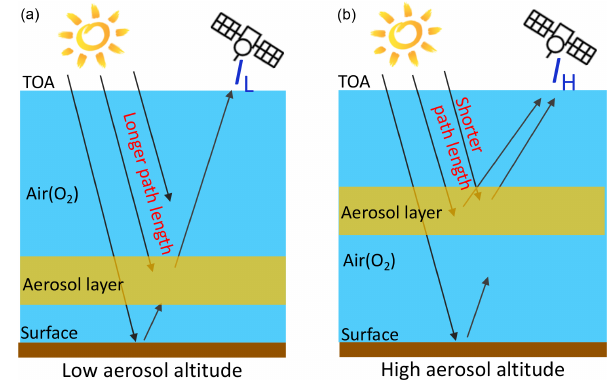
Figure 2. Schematic diagram of the physical principle of the remote sensing of aerosol layer height in the O 2 absorption bands. Shown is the same aerosol layer located at two different altitudes in the at- mosphere. Due to the scattering by aerosol particles, light scattered by a higher aerosol layer (b) would travel a shorter path length to reach the satellite sensor than those scattered by the lower-altitude aerosol (a) , resulting in less absorption by O 2 and thus a higher radiance value detected by the satellite (i.e., I H > I L